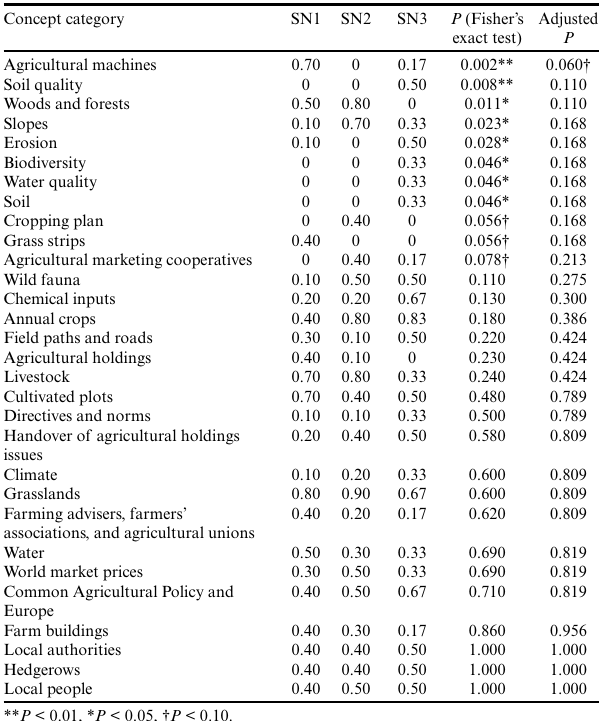
Table 6. Concepts tested during the comparative analysis of farmer groups based on types of semi-natural areas management practices (typology